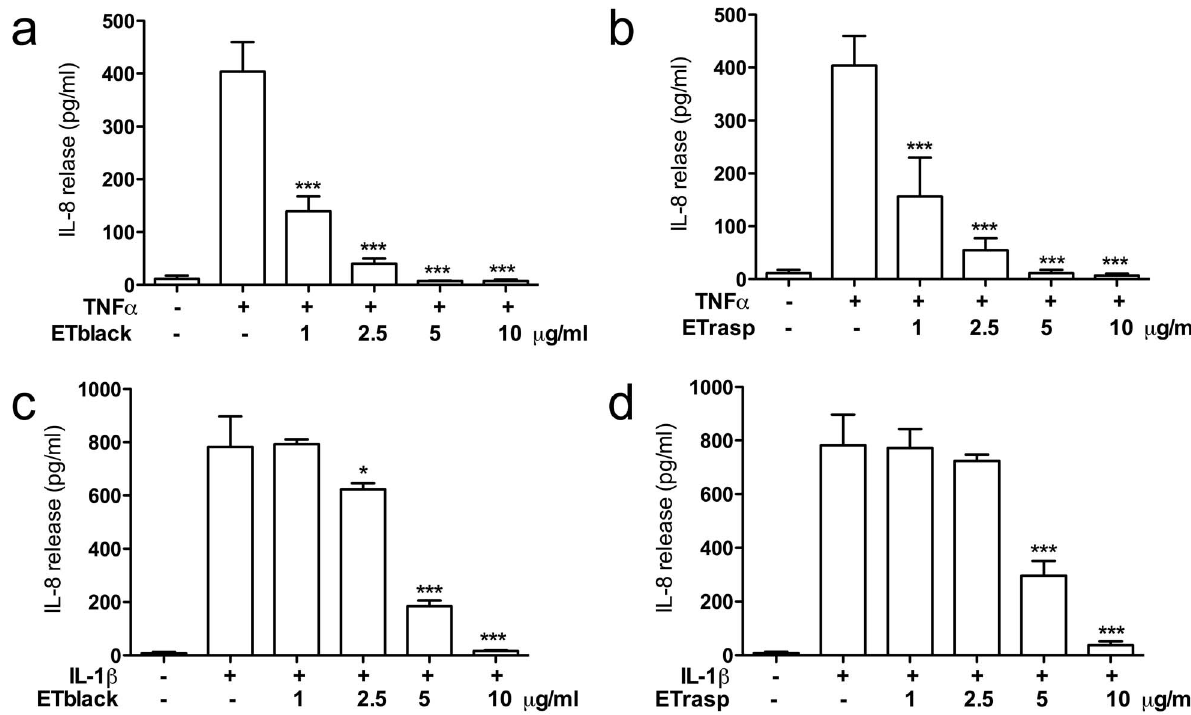
Figure 5. Effect of ETs from blackberry and raspberry on IL-8 release induced by TNF a and IL-1 b . AGS cells at confluence were placed in a medium deprived of FCS, and stimulated with 10 ng/ml TNF- a (panel a and b) or IL-1 b (panel c and d) for 6 hrs. IL-8 was quantified by using Interleukin-8 High Sensitivity Human ELISA Set (Immunotools, Germany). The amount of IL-8 in the samples was detected by spectroscopy (signal read 450 nm, 0.1 s) by the use of biotinylated and streptavidin-HRP conjugate antibodies, evaluating 3,5,3,5 9 -tetramethylbenzidine (TMB) substrate reaction. Inhibition by 5 m M parthenolide, used as reference inhibitor, was 70% for both TNF- a and IL-1 b induced IL-8 secretion. Results are the mean 6 sd of three experiments in triplicate. * p , 0.05, ***p ,